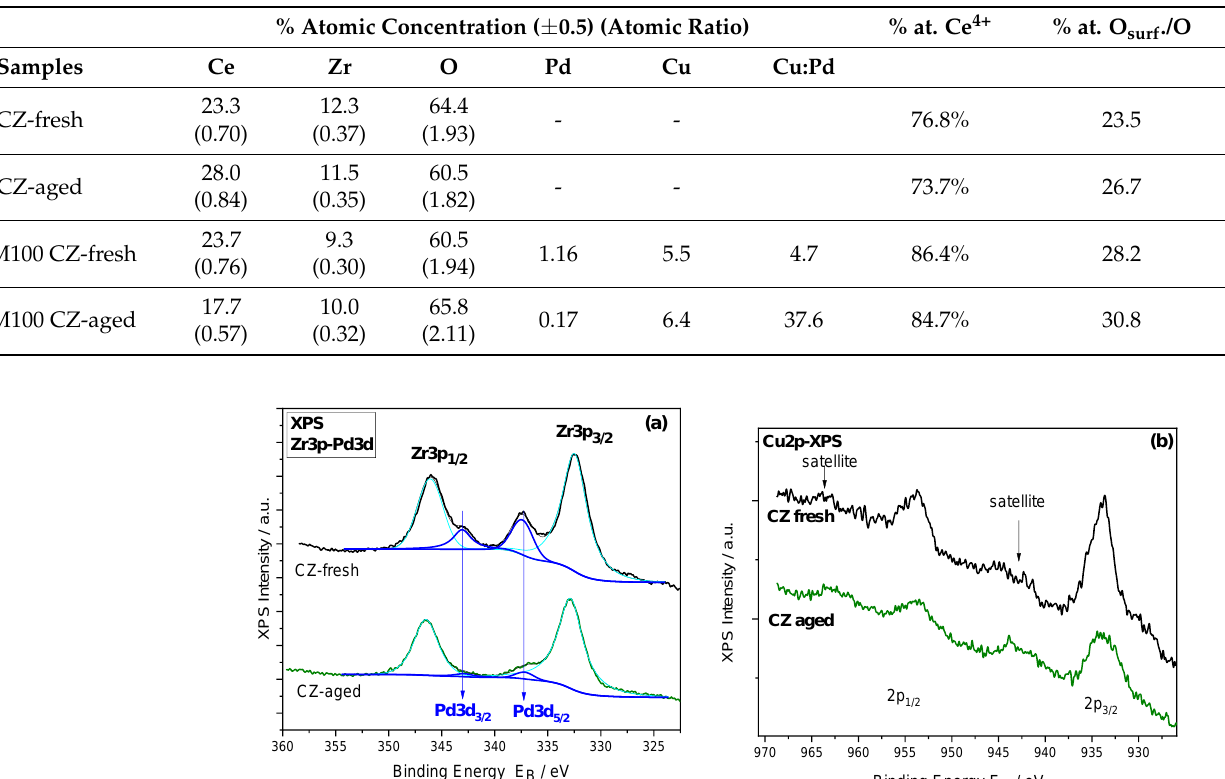
Table 3. XPS results of CZ and PROM100-fresh and -aged materials.